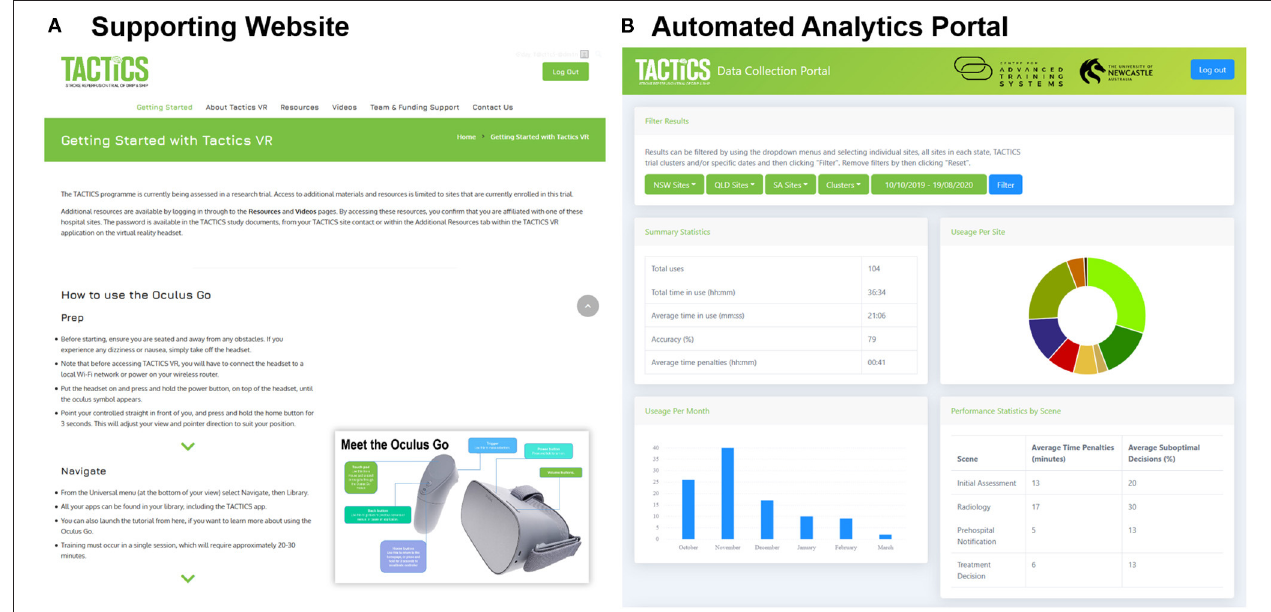
FIGURE 3 | TACTICS VR supporting training environment. The TACTICS VR integrates. (A) A supporting website providing user support and educational resources and (B) automated back-end data analytics portal for capture of training uptake and user performance.